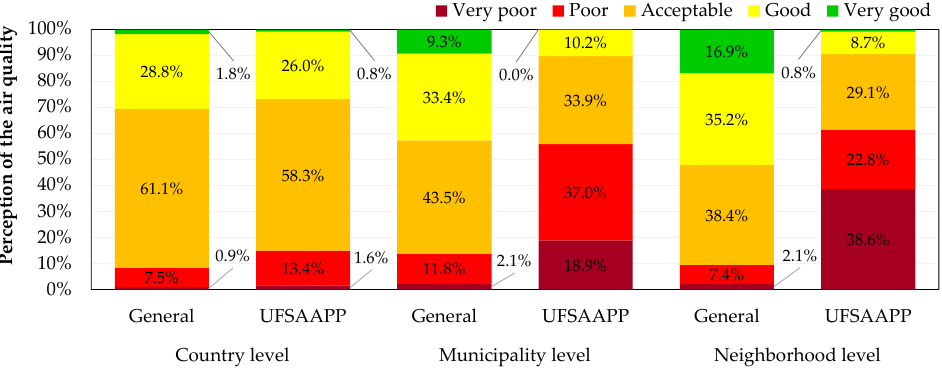
Figure 4. Assessment of the perception on air quality in Portugal, at country, municipality and neighborhood levels for the general and UFSAAPP populations.